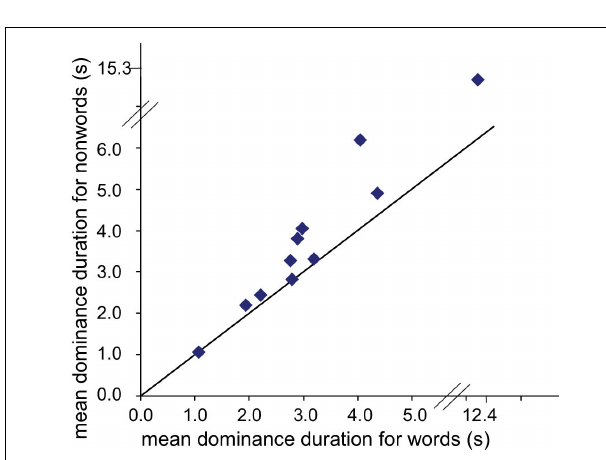
FIGURE 5 | Dominance durations – possible vs. impossible figures. Across-subject mean dominance durations for possible and impossible figures for the different classes of images. Simple impossible figures have longer dominance durations than possible figures, with no difference for complex